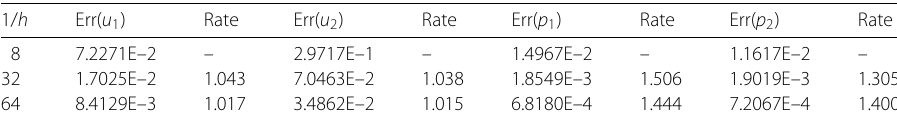
Table 1 Errors for stabilized P 1 – P 1 pair with τ = h